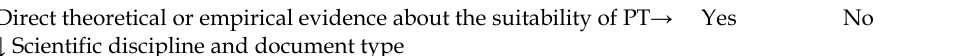
Table 1. Characterization of the entries in the bibliography Direct theoretical or empirical evidence about the suitability of PT→ ↓ Scientific discipline and document type